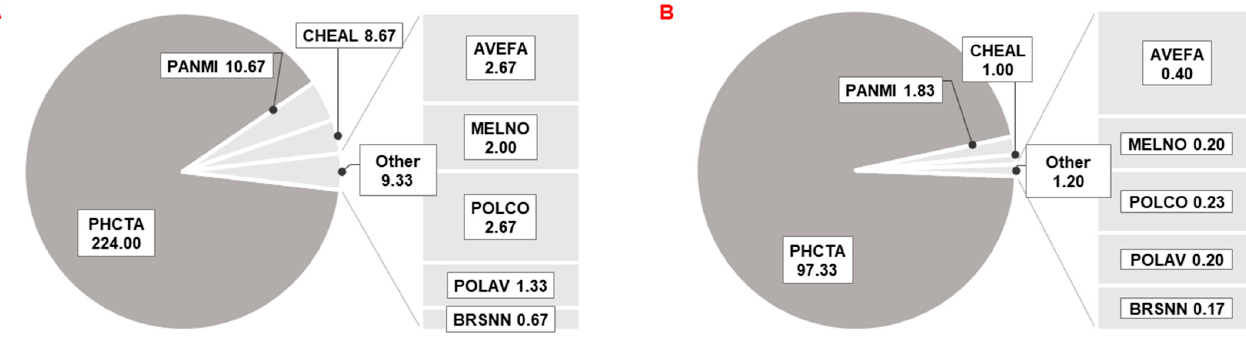
Figure A8. Number of plants per m 2 —Sowing 2 (22nd of April) in 2020 ( A ) and leaf coverage in %— Sowing 2 (22nd of April) in 2020 ( B ). Figure A9. Number of plants per m 2 —Sowing 3 (7th of May) in 2020 ( A ) and leaf coverage in %— Sowing 3 (7th of May) in 2020 ( B ).